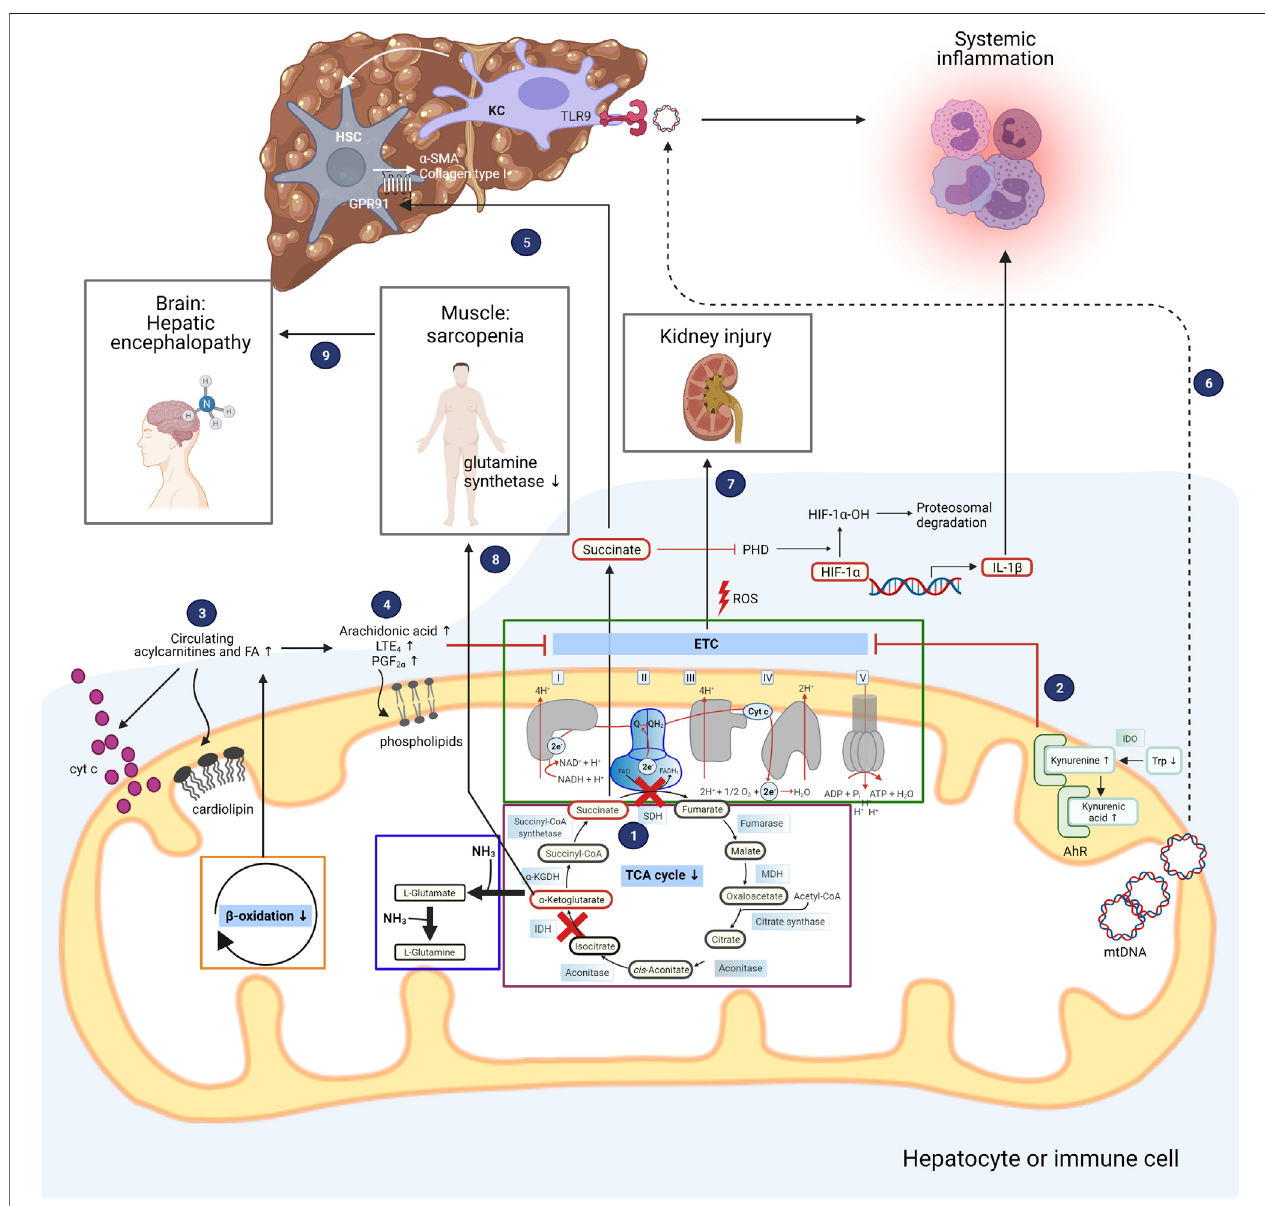
FIGURE 1 | Deranged mitochondrial intermediate metabolism contributes to development of organ dysfunction in patients with acute decompensated liver cirrhosis. The different metabolic intermediate pathways located in mitochondria are depicted, and how their derangements contribute to the clinical symptoms of patients with acutely decompensated liver cirrhosis. The boxes inside the mitochondrion highlight the electron transport chain (ETC), the tricarboxylic acid (TCA) cycle, andglutaminesynthesisasonepossiblepathwayforammoniadetoxi fi cation.PeripheralmononuclearcellsofpatientswithACLFexhibitadiscontinuousTCAcycle at the isocitrate and succinate dehydrogenase (IDH and SDH) level (1) . Succinate is transported into the cytosol where it inhibits prolyl hydroxylase (PHD), resulting in stabilization of hypoxia-inducible factor-1 α (HIF-1 α ) and enhanced production of interleukin-1 β (IL-1 β ). Untargeted metabolomics in serum of patients with AD cirrhosis and ACLF revealed increased degradation of tryptophan (Trp) through the kynurenine pathway with elevated kynurenine and kynurenic acid levels, which bind to aryl hydrocarbonreceptor(AhR)localizedintheintermembranespaceofmitochondria (2) .ActivationofAhRisimplicatedinattenuationofmitochondrialmaximalrespiration. Patients with AD cirrhosis and ACLF also exhibit elevated levels of fatty acids and acylcarnitines, pointing towards impaired β -oxidation (3) . Saturated fatty acids (FA) changethecompositionofcardiolipinswhichareenriched intheinnermitochondrialmembrane,facilitatingthereleaseofcytochromec.Targetedstudyofbioactive lipid mediatorsinpatientswithADcirrhosisandACLFrevealedelevated levelsofarachidonicacidanditsproductsLTE 4 andPGF 2 α (4) .Arachidonicacidisabletomodifythe phospholipidcompositionofmitochondrialmembranes,resultinginimpaired functionoftheETC.Inadditiontobeinginvolvedinpro-in fl ammatory responses, succinate promotes fi brogenesisthroughitsreceptorGPR91whichisexpressedonhepaticstellatecells(HSC),leadingtoupregulationofalpha-smoothmuscleactin( α -SMA)and collagen type I (5) . Mitochondrial DNA (mtDNA) released from hepatocytes promote in fl ammation through binding to toll-like receptor 9 (TLR9) of liver resident Kupffer cells(KC) (6) ,furthercontributingto fi brogenesis.Reactiveoxygenspecies(ROS)generatedbytheelectrontransportchainandreleasedbymitochondriapromotecelldeath of kidney cells, eventually leading to kidney dysfunction and failure (7) . Hyperammonemia in patients with advanced liver cirrhosis leads to depletion of α -ketoglutarate in skeletal muscle and consequently lower TCA fl ux and ATP synthesis, translating into sarcopenia (8) . Along with muscle loss, signi fi cant amounts of glutamine synthetase activity is lost, promoting hepatic encephalopathy (9) . IDO, indoleamine-2,3-dioxygenase; MDH, malate dehydrogenase. Figure was created with BioRender.com.